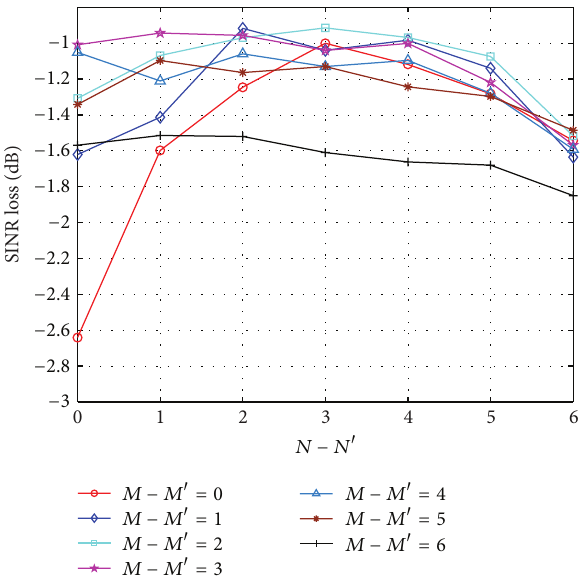
Figure 3: SINR loss versus the sizes of 𝑁 − 𝑁 󸀠 and 𝑀 − 𝑀 󸀠